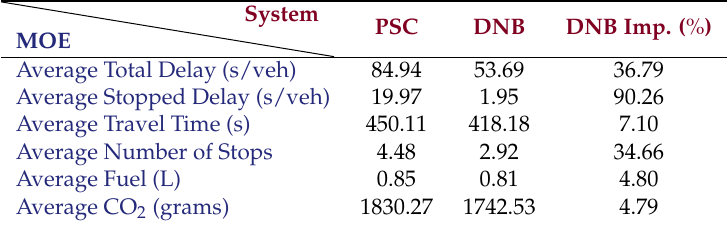
Table 10. Average MOEs and the (%) improvement using DNB over PSC controller (10% Demand).